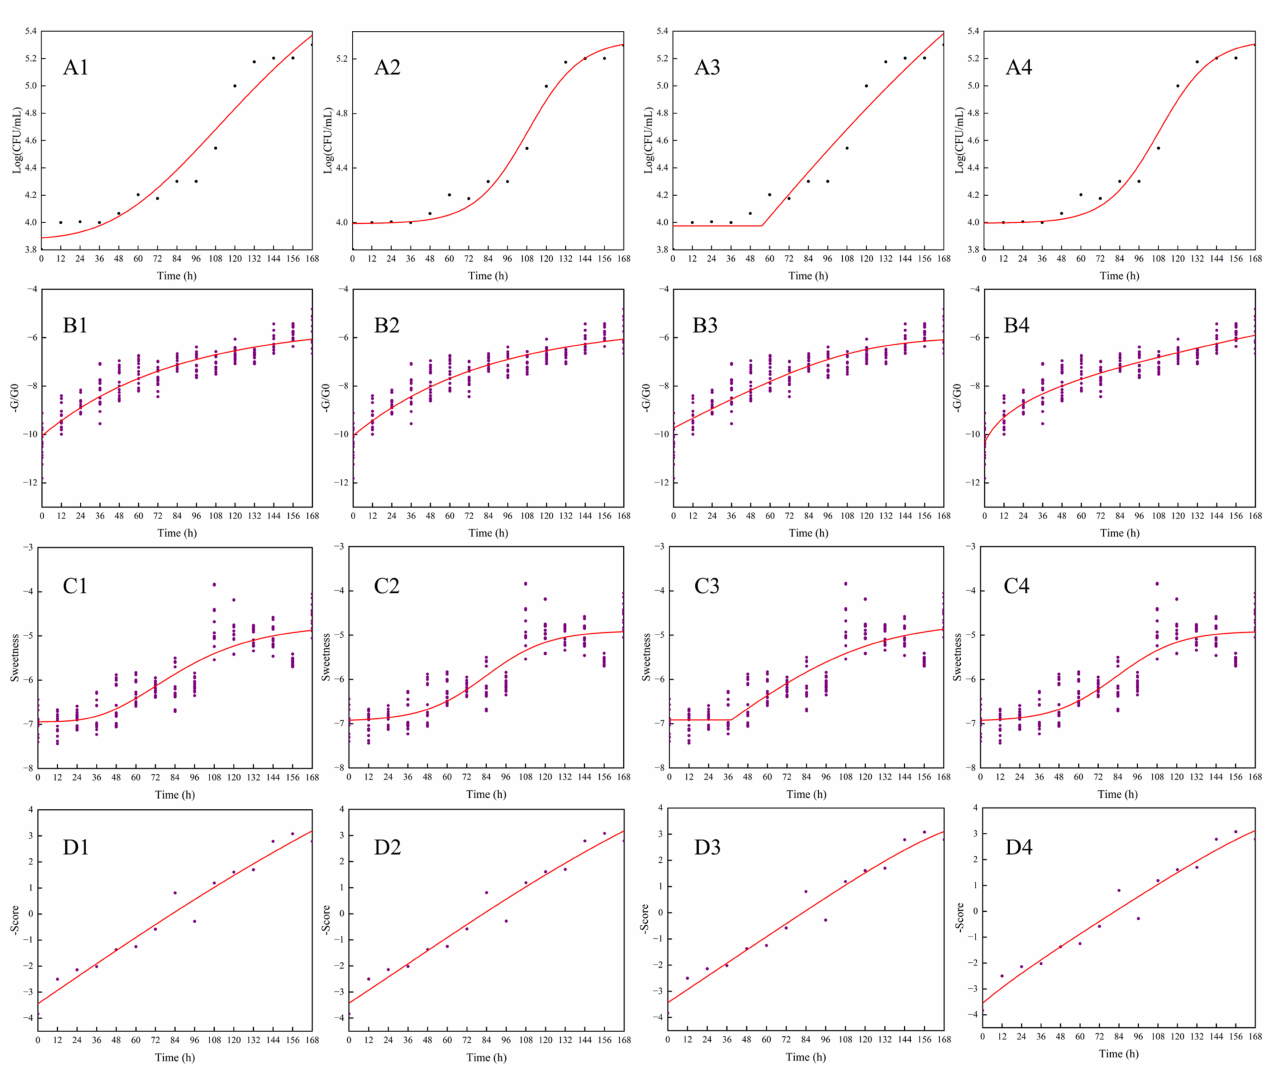
Figure 1. Fitting of the Modified Gompertz, Logistic, Huang and Baranyi models to the total bacterial count ( A1 – A4 ), the response values of S7 ( B1 – B4 ), sweetness ( C1 – C4 ) and the scores of PC1–PC4 extracted from E-nose and E-tongue readings ( D1 – D4 ) for freshly squeezed strawberry juice during cold